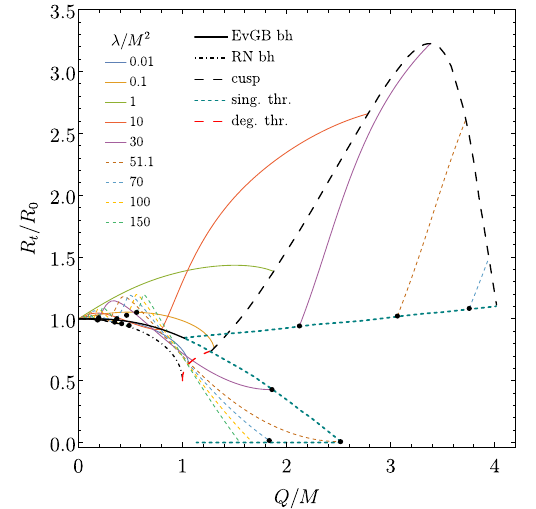
Fig. 13 Vector field at the throat vs. scaled vector charge for coupling function (i)